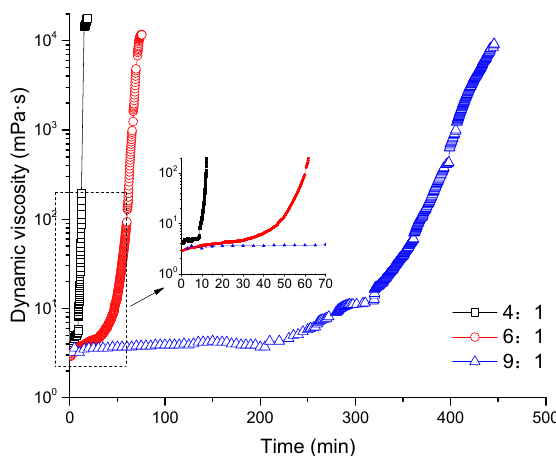
Figure 6. Time-varying curves of viscosity with different ratios between silica sol and accelerator (volume). The experimental data can be expressed by the first-order decay exponential function. Dynamic viscosity of silica sol has maintained at a low level below 10 mPa·s before gelling.